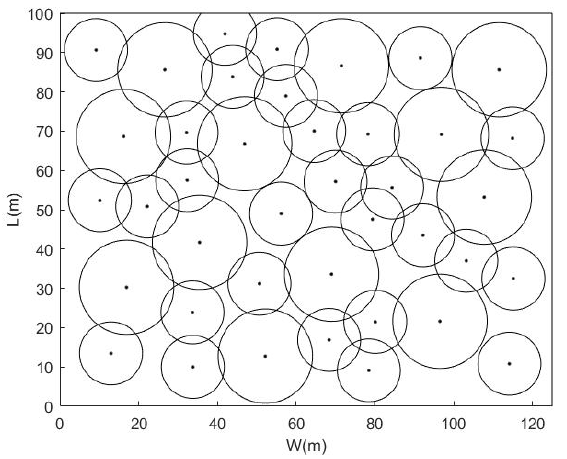
Figure 8. Nodes after patching by our